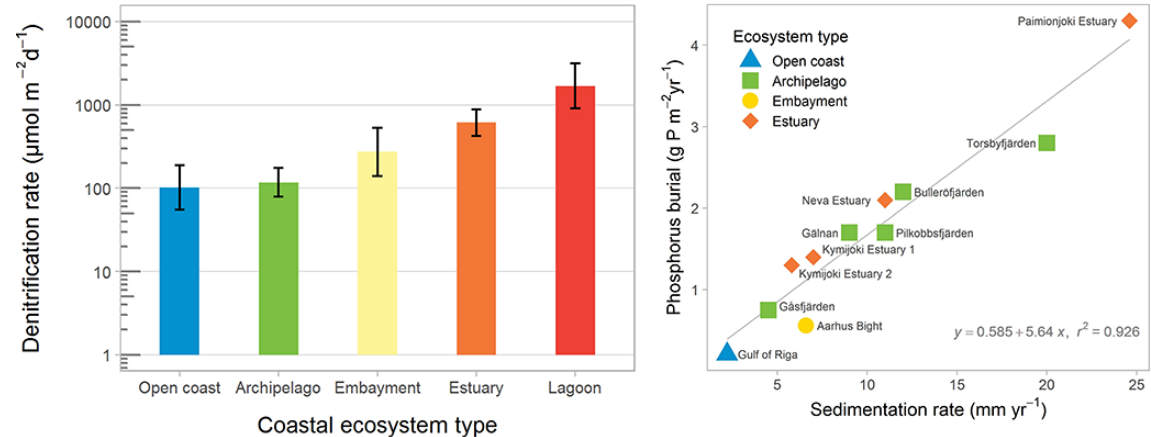
Figure 3. Mean denitrification rates in coastal ecosystem types in the Baltic Sea (left panel). Error bars show the 95% confidence intervals for the mean estimates. The relationship between sedimentation accumulation rate and phosphorus burial in 11 study sites across the Baltic Sea (right panel). Redrawn from Asmala et al.